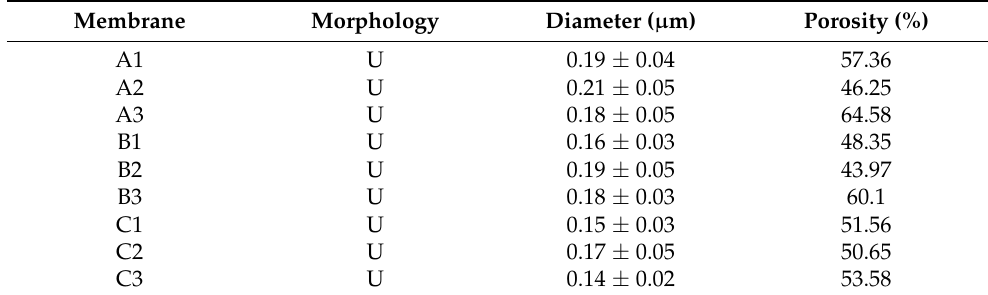
Table 3. Fiber diameter and porosity of the different irinotecan-loaded membranes using different electrospinning fabrication parameters and polymer solutions in the inner and outer nozzles.